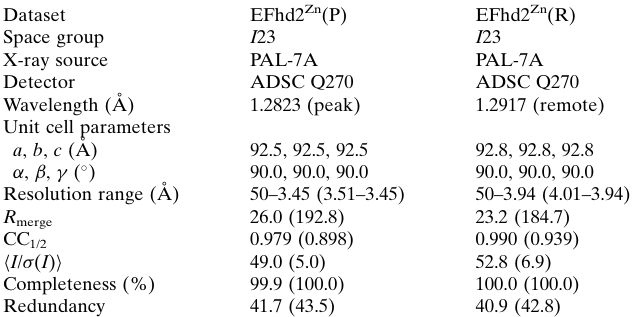
analyze the anomalous signals described in Fig.